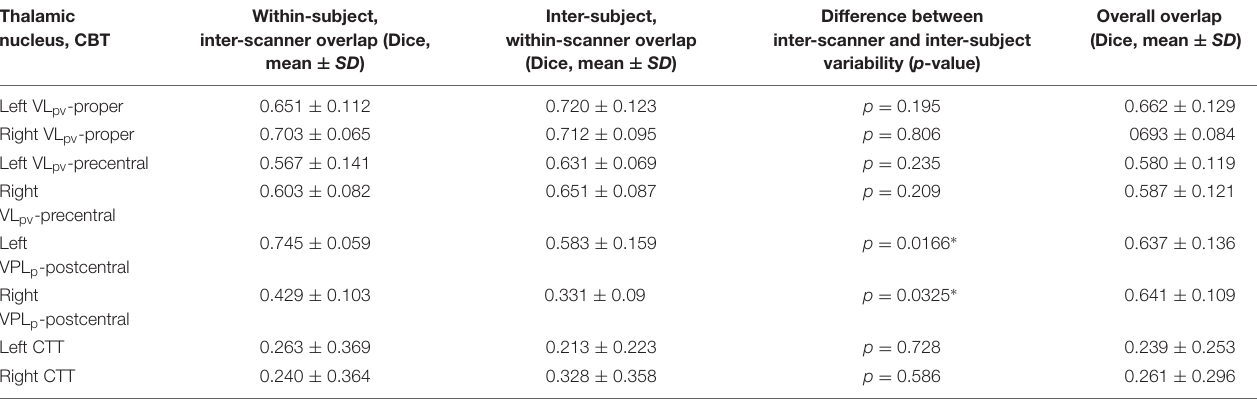
Overall overlap (Dice, mean ± SD )